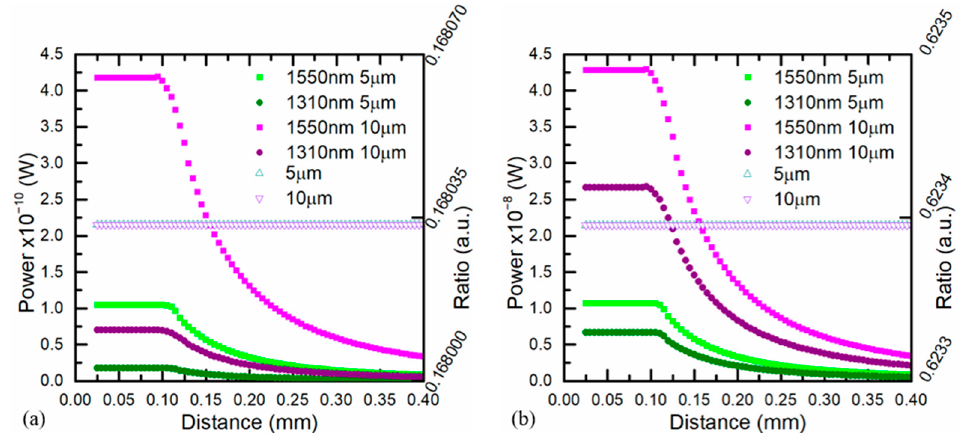
Figure 13. Energy recovered by the optical fiber at both wavelength bands for different target sizes (5 and 10 µ m) at ( a ) 500 ◦ C and ( b ) 1000 ◦ C. The right y-axis in both cases shows the ratio (unfilled markers) between both wavelength channels for the different target sizes.